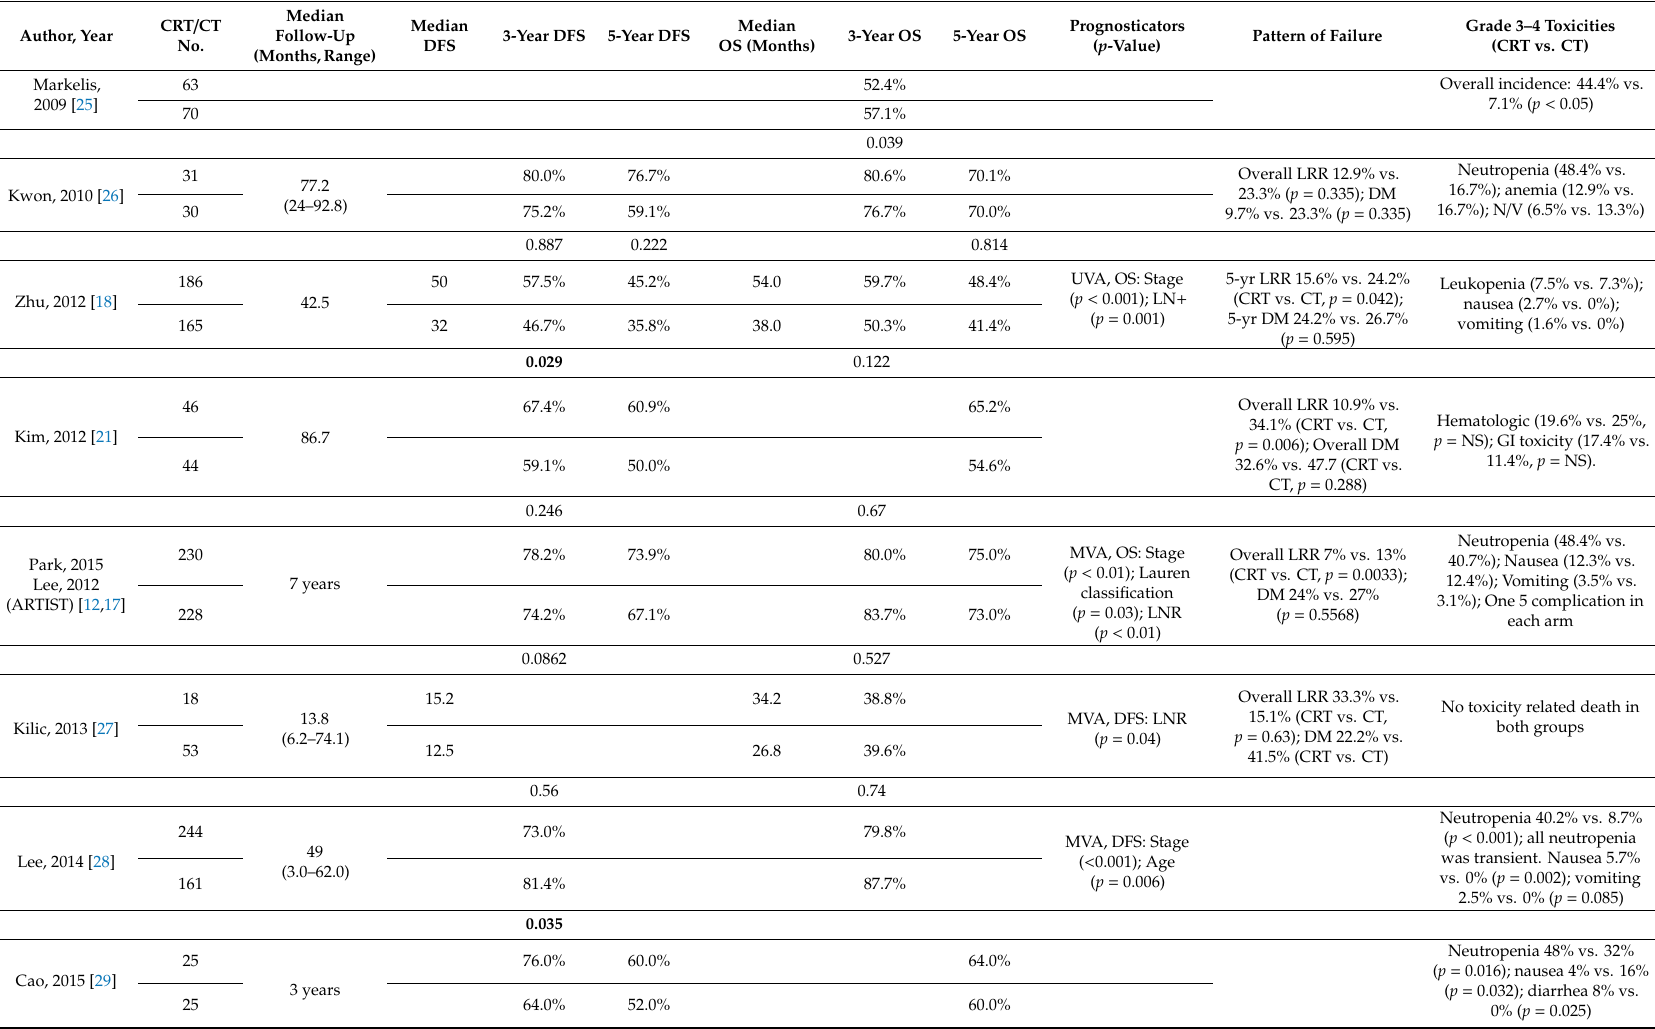
Table 2. Clinical outcomes of patients in the included